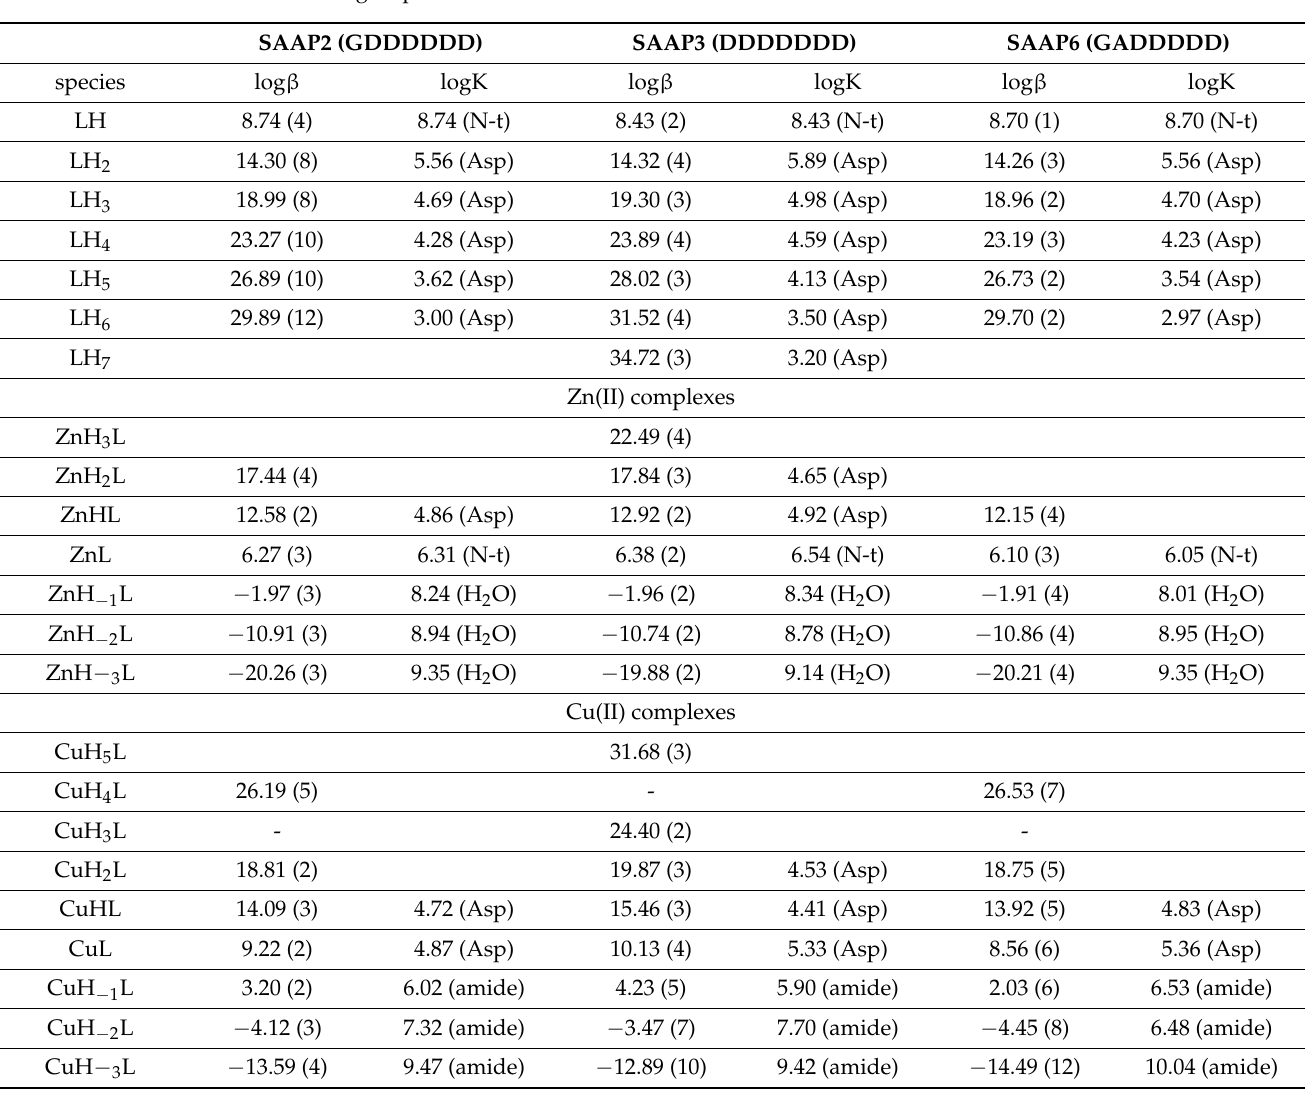
Table 1. Potentiometric data for proton, Zn(II) and Cu(II) complexes with SAAP2 (GDDDDDD), SAAP3 (DDDDDDD) and SAAP6 (GADDDDD). Titrations were carried out over the pH range 2–11 at T = 298 K in an aqueous solution with 4 mM HClO 4 and 0.1 M NaClO 4 . The peptide concentration was 0.5 mM and the Zn(II)- and Cu(II)-to-peptide ratio was 1:1. HYPERQUAD 2006 [16] was used to determine the stability constants. Standard deviations are shown in brackets. N-t refers to the N-terminal amine